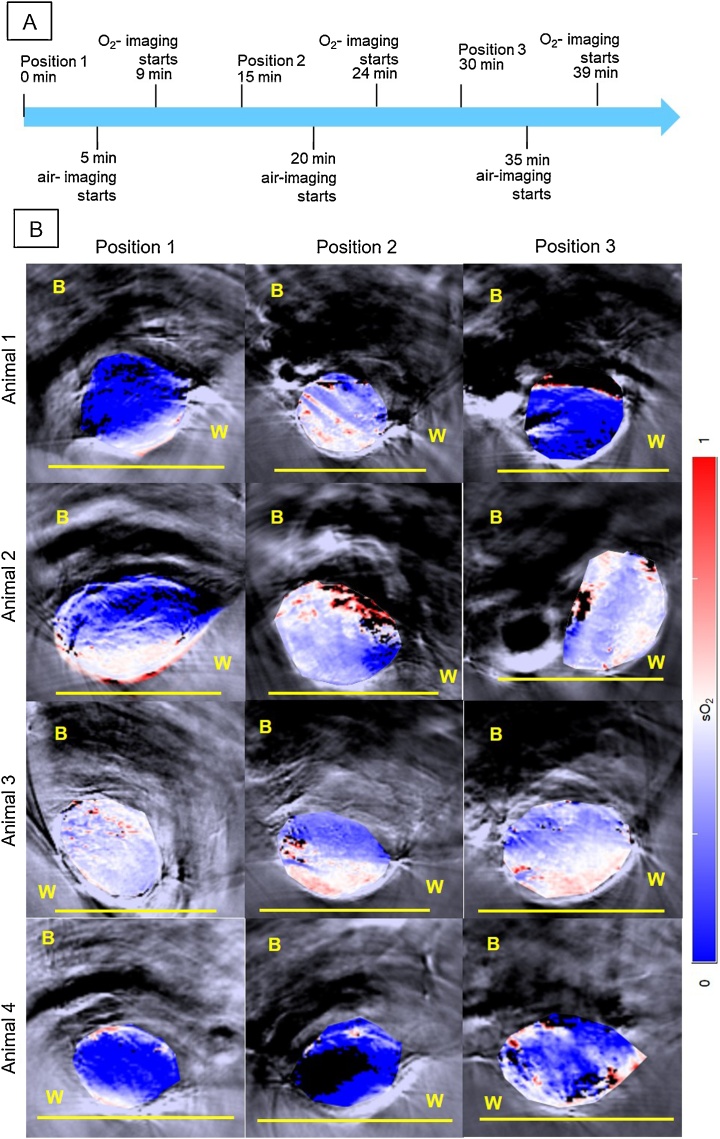
A: Diagram for the re-positioning of the animal. Each air-breathing imaging session started at approximately 5, 20 and 35 min after placing the animal in the water tank of the MSOT system. Air-breathing imaging takes approximately 2 min. The air is then changed for 100%-O2, for 2 min and the same tumour region is re-imaged for approximately 2 min again, during O2-breathing. B: sO2 distributions or ‘oxymaps’ of 4 CALR tumours, positioned differently by remounting the animals 3 times in the MSOT tank with the minimum time interval between each imaging session. The ‘oxymaps’ are shown as overlays on greyscale photoacoustic images, of the central slice of each tumour. B: body; W: water. Yellow bar represents a 10 mm size scale.